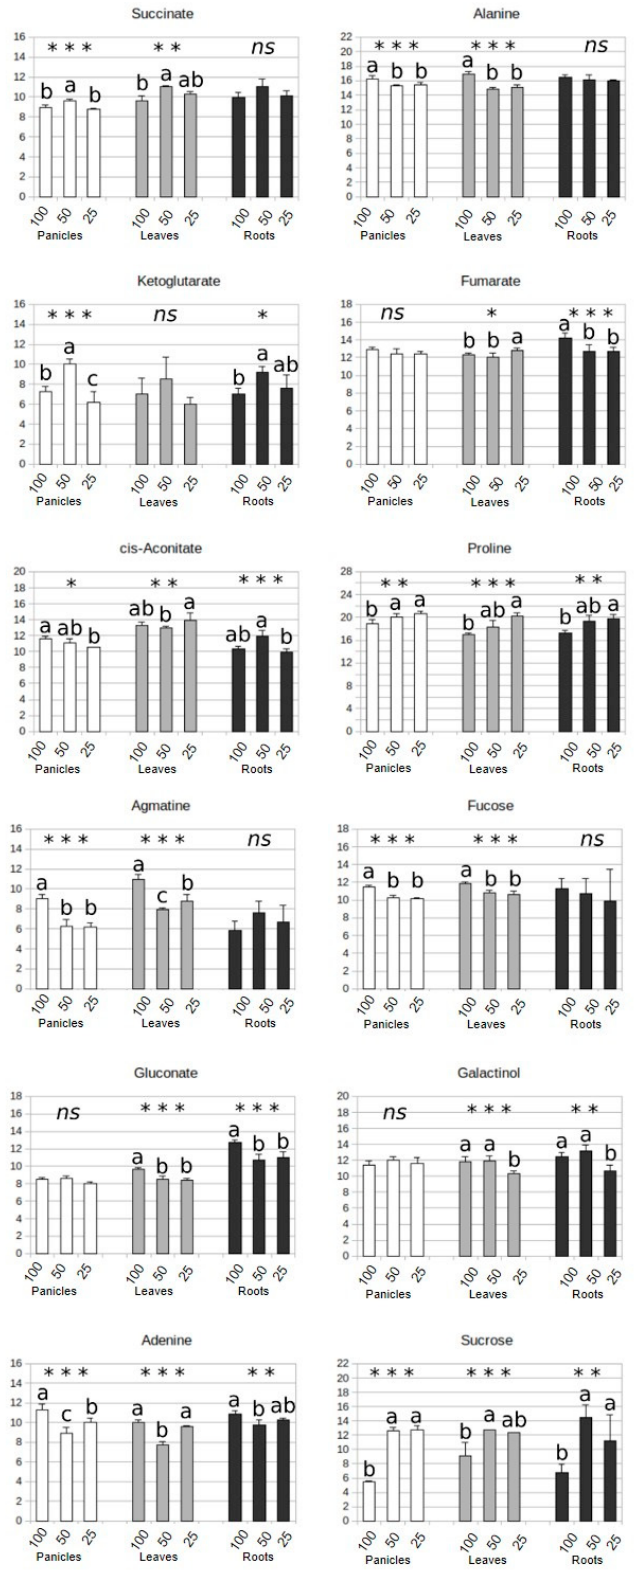
Figure 5. Potential bioindicators (loading score >0.40) of water limitation in S. viridis . Different letters indicate significant differences ( p < 0.05) between the water treatments in the same plant organ. Along the X axis, the numbers 100, 50, 25 refer to the water treatments. Asterisks indicate significant effects: * p ≤ 0.05; ** p ≤ 0.01; *** p ≤ 0.001; ns = not significant.